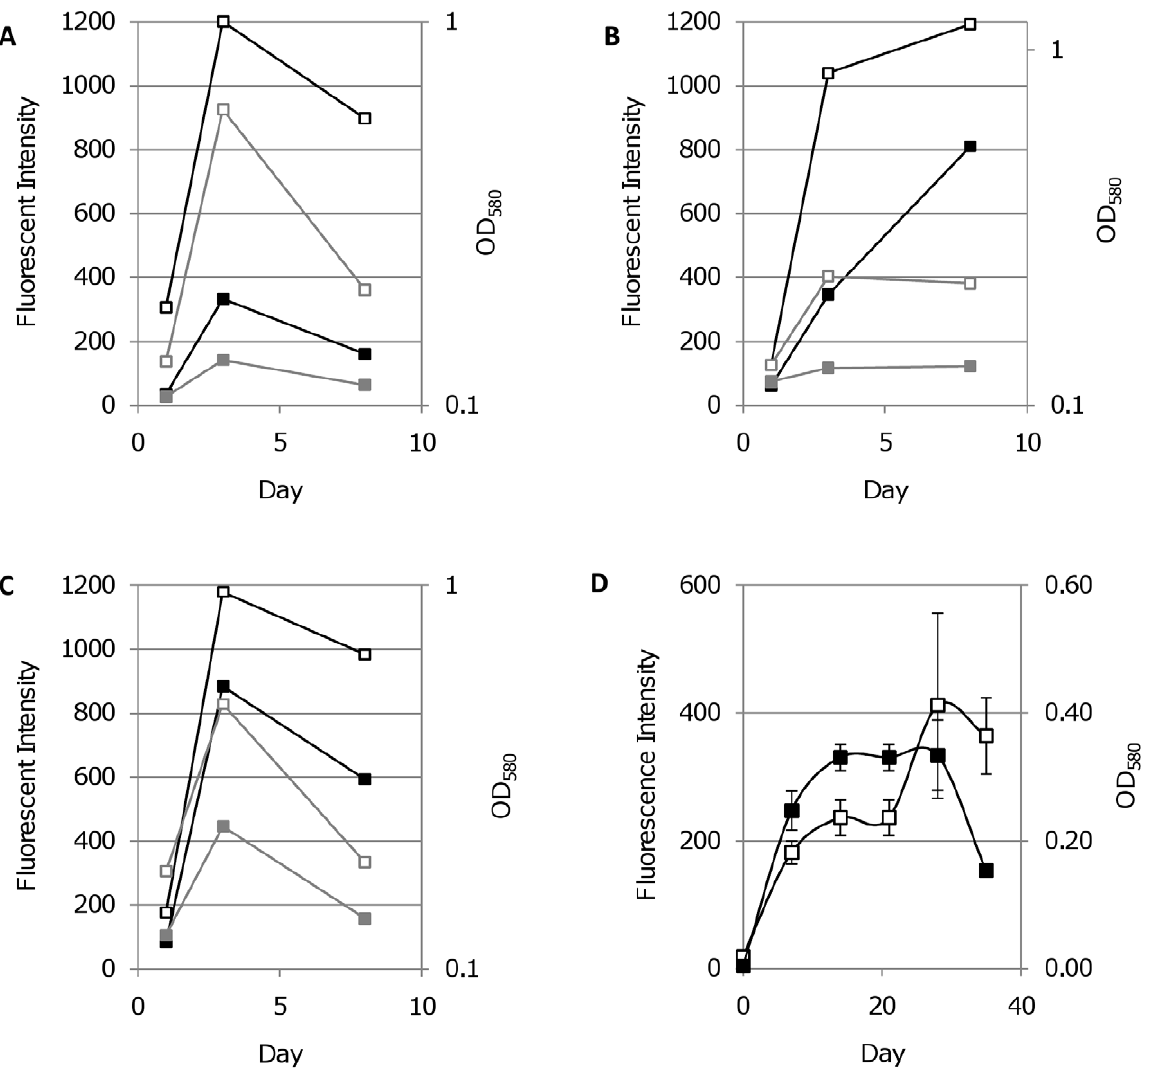
Figure 13. FP activity under hypoxic conditions. M. smegmatis (A to C) transformants expressing FPs from P smyc were cultured aerobically (black lines) or under limiting oxygen (grey lines) conditions. Fluorescence intensity (solid squares) and OD 580 (open squares) were measured. A - M. smegmatis expressing mCherry. B - M. smegmatis expressing tdTomato. C - M. smegmatis expressing Turbo-635. D - M. tuberculosis expressing mCherry under hypoxic conditions. M. tuberculosis transformants expressing FPs from P smyc were cultured under limiting oxygen conditions. Fluorescence intensity (open squares) and OD 580 (solid squares) were measured.